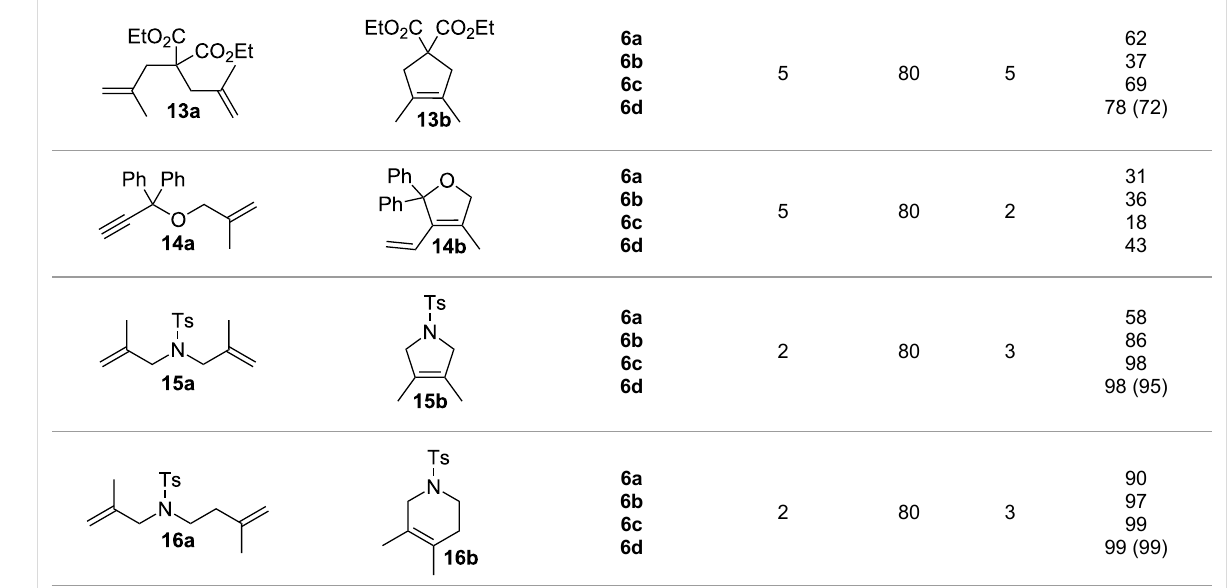
Table 2: Catalytic evaluation of 6a–d in benchmark metathesis transformations. a